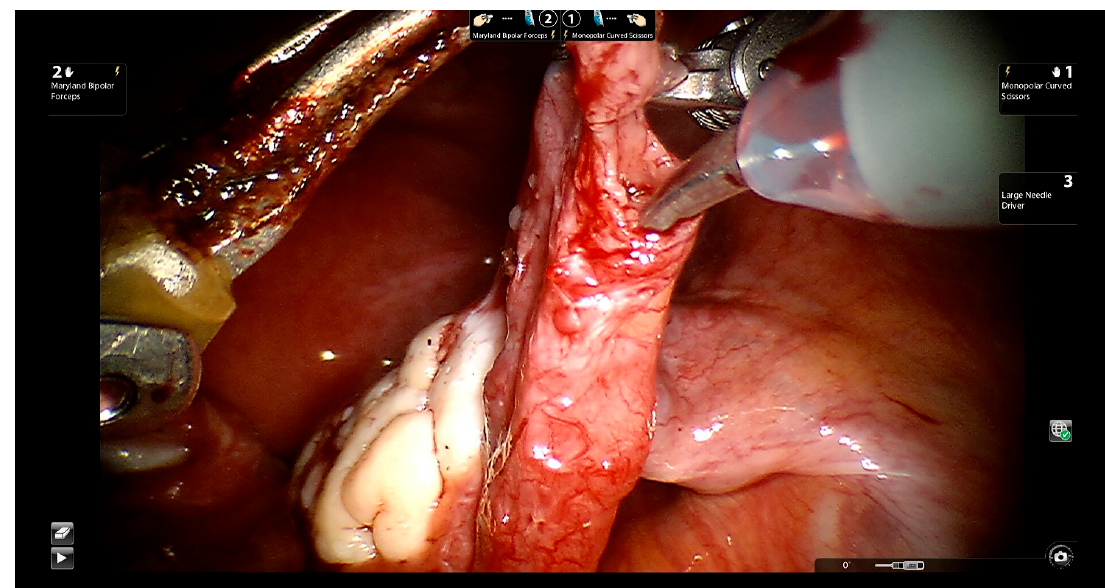
Figure 5. Opening the proximal and distal ends of the tube. Reconstruction of the mesosalpinx: A series of 6-0 Vicryl stitches are performed to bridge the gap between the ends of the fallopian tube and facilitate the placement of fine sutures subsequently. The tubal segments are thus brought closer and tension on the anastomosis is prevented. If the proximal and distal anastomosis sites differ markedly in size, a stent is inserted to facilitate suturing of the two ends. Tubal reanastomosis: Four to six interrupted 5-0 Vicryl sutures or PDS are used to suture the mucosal and muscular layers of the tubal segments (Figure